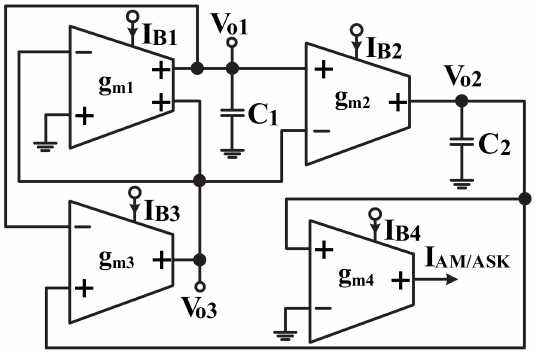
Figure 3. Proposed VM OTA-C QO with amplitude of output